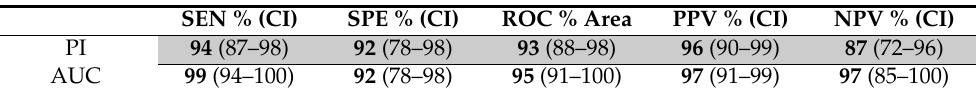
Table 5. Diagnostic performance of quantitative evaluation performed by CEUS (SEN: Sensitivity; SPE: Specificity; ROC: Receiver Operating Characteristics; PPV: Positive Predictive Value; NPV: Negative Predictive Value; PI: Peak Intensity; AUC: Area Under the Curve).